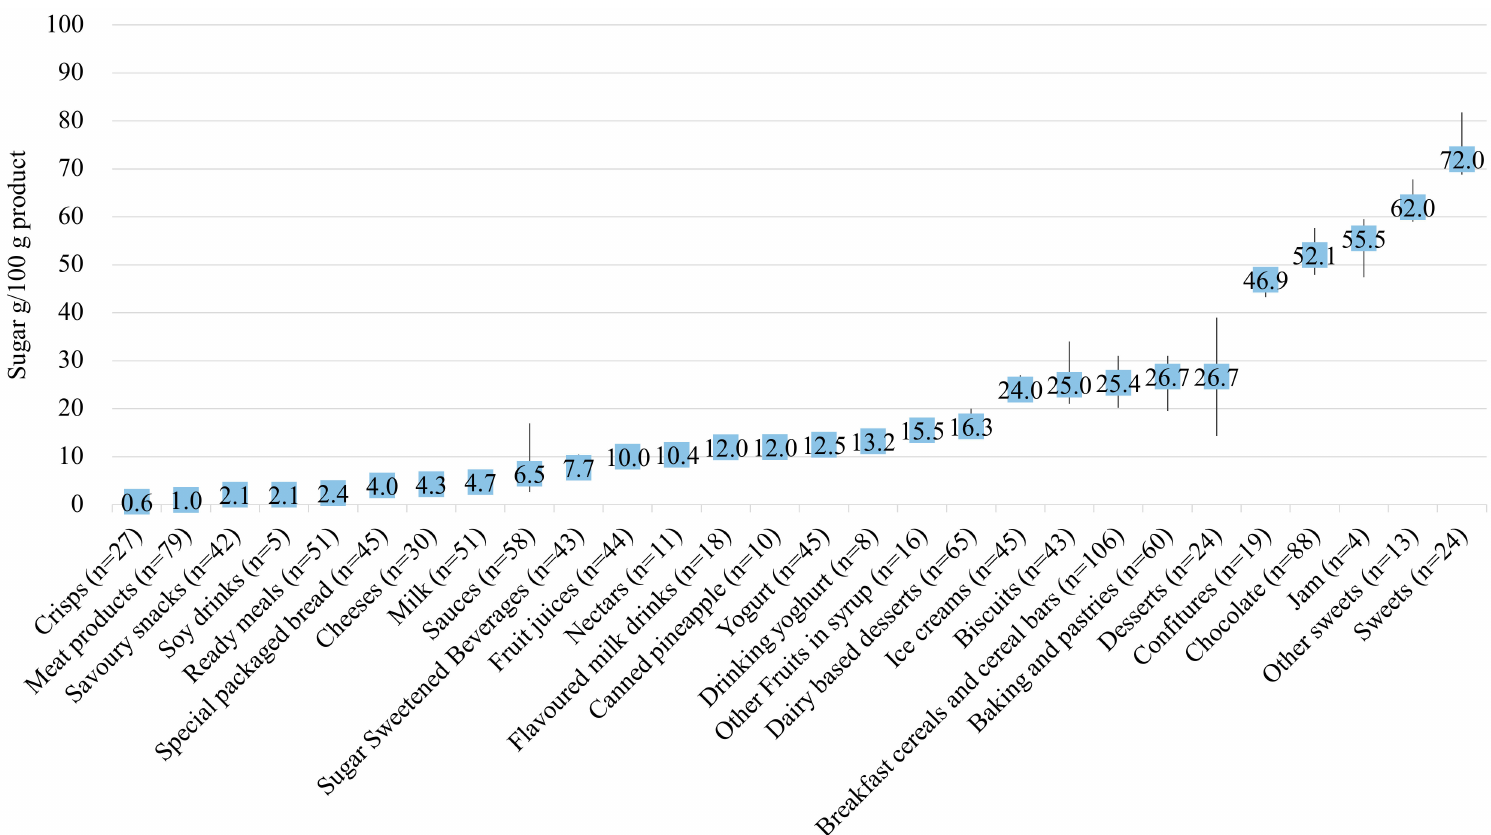
Figure 2. Median and 25th and 75th percentiles of label values (LV) for total sugar for the most consumed groups of products in